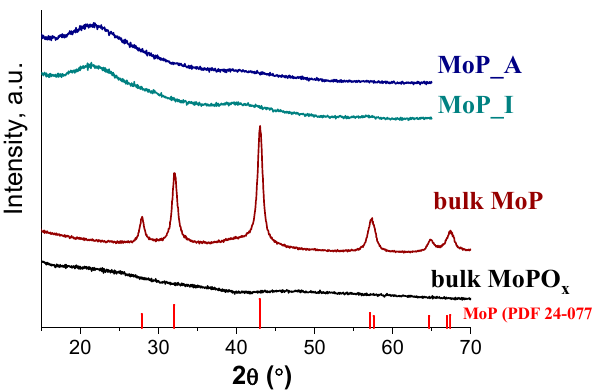
Figure 2. XRD of reduced MoP_A, MoP_I and bulk MoP samples and unreduced MoP precursor.